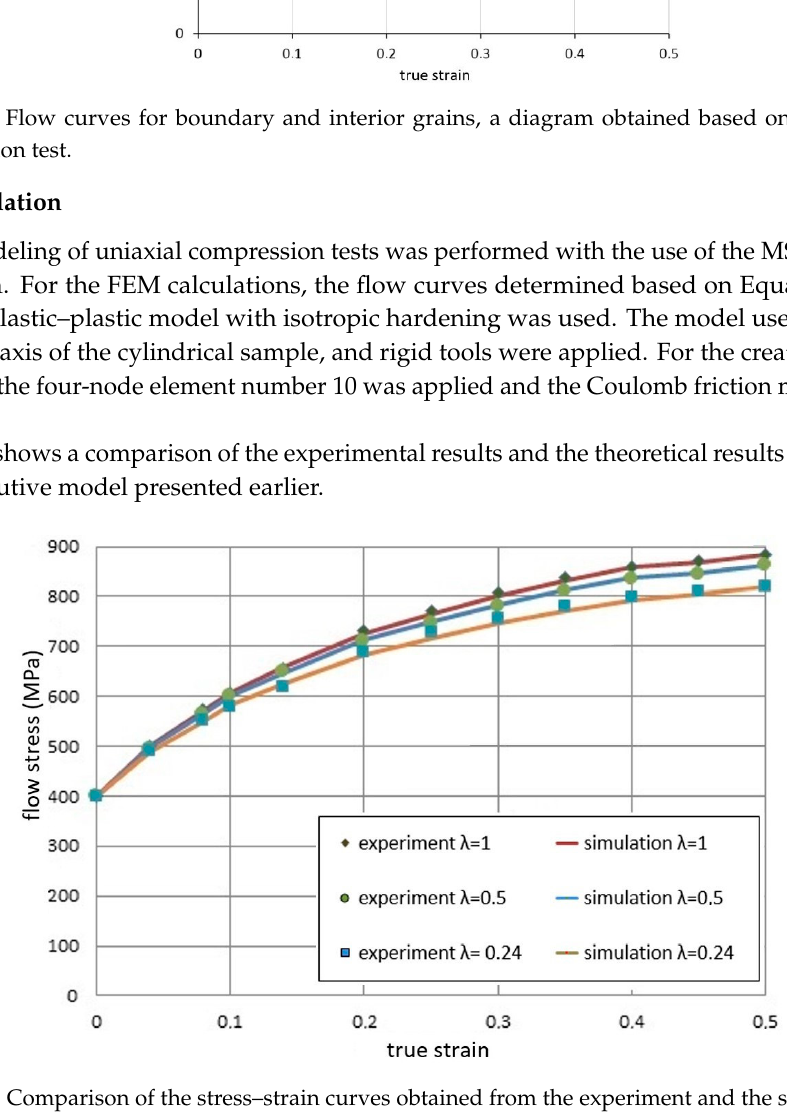
compression test.